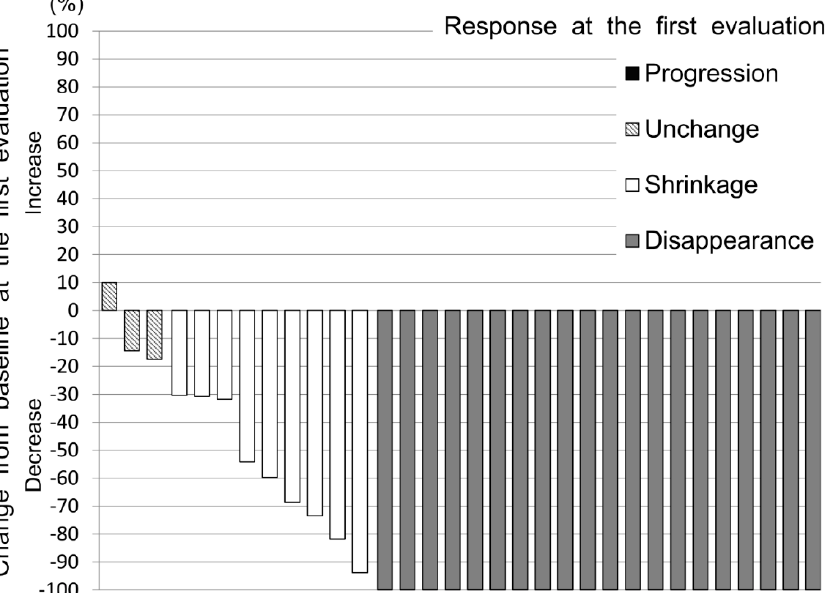
Figure 3. Waterfall plot of confirmed change from baseline at the first evaluation.